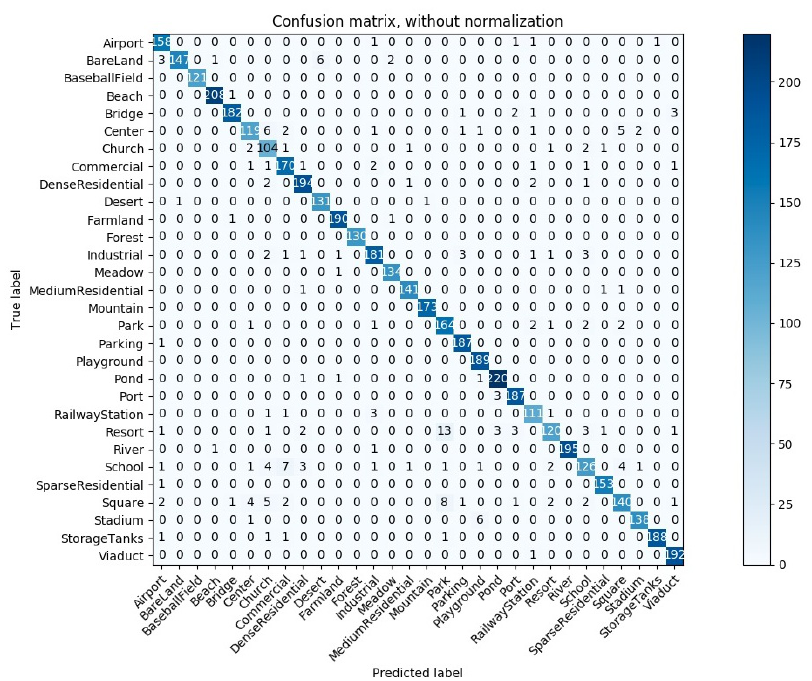
Figure 10. Confusion matrix of the proposed method with a 50%/50% train/test ratio of AID data set for ResNet50, linear learning rate decay, and a linear SVM